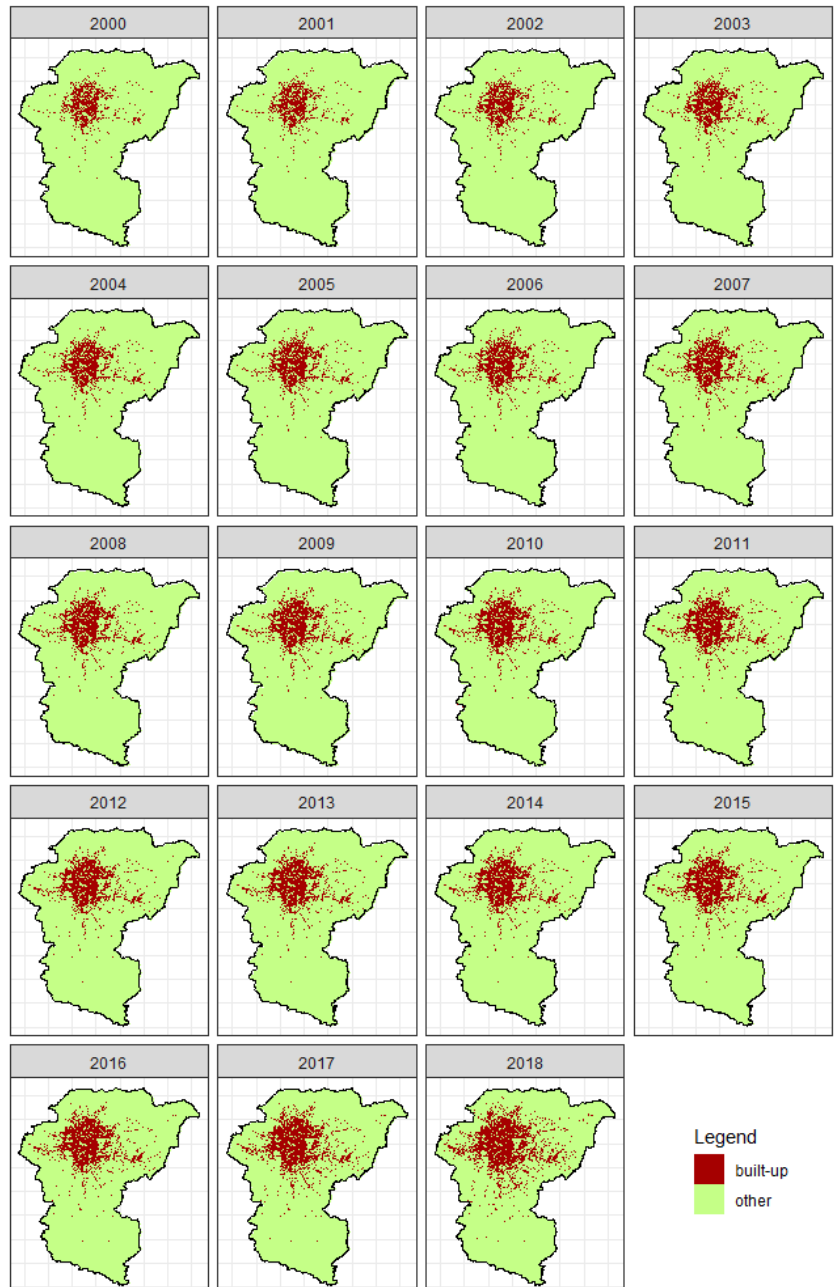
Figure 7. Built-up time-series maps of the study region starting from 2000 to 2018 showing built-up areas (red) and other areas (green): The urban sprawl patterns can be seen from the increase in built-up area